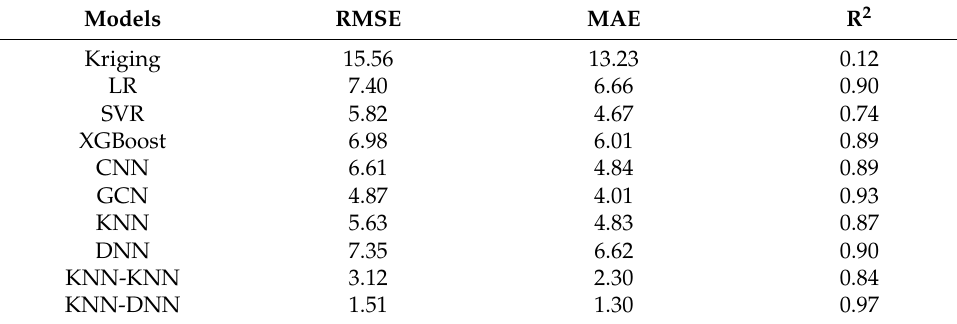
Table 2. Comparison of different models.